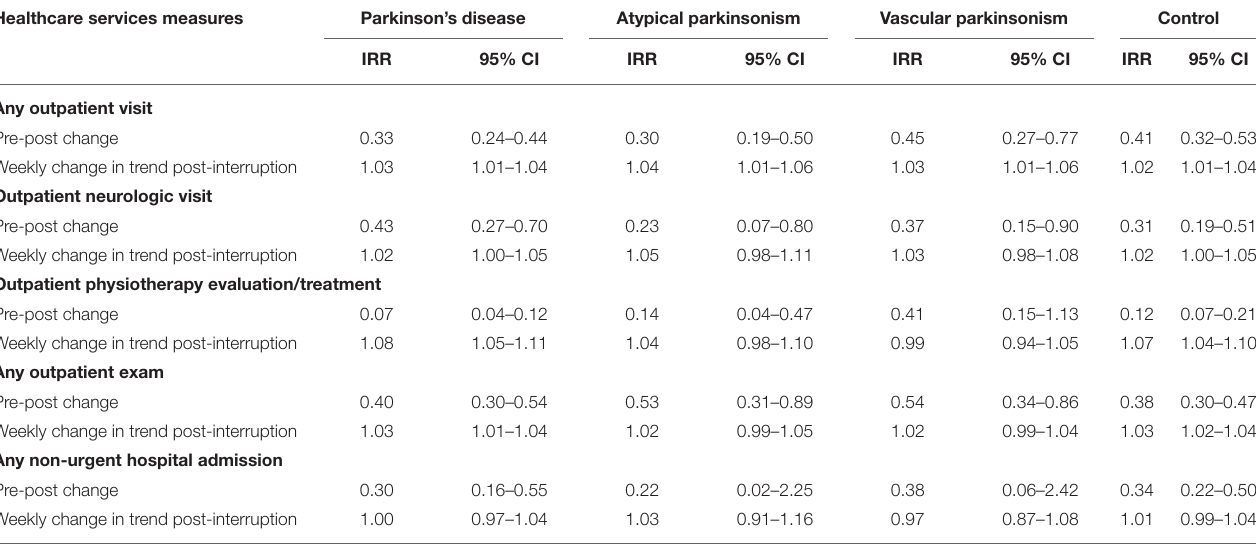
TABLE 3 | Interrupted time series of healthcare services measures in the ParkLink cohorts (Parkinson’s disease, atypical parkinsonism, vascular parkinsonism) and the control cohort, local health trust of Bologna, from July 1, 2019 to September 30,